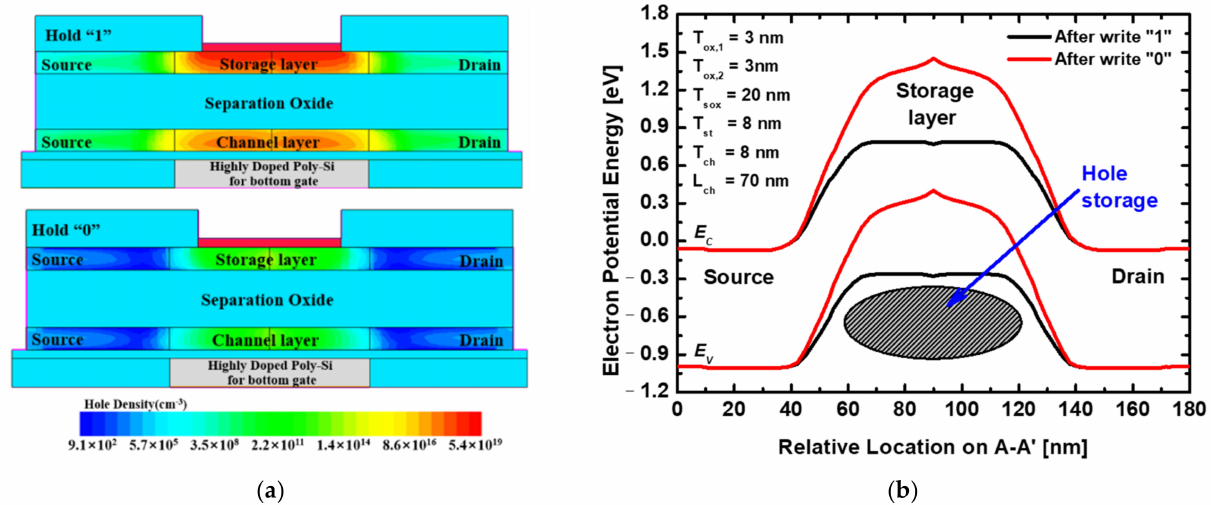
Figure 6. ( a ) Simulation profile of the proposed 1T-DRAM during the hold operation showing hole density. ( b ) Energy band diagram of the storage layer during the hold operation. The energy band is extracted at 2 nm below the top gate oxide.